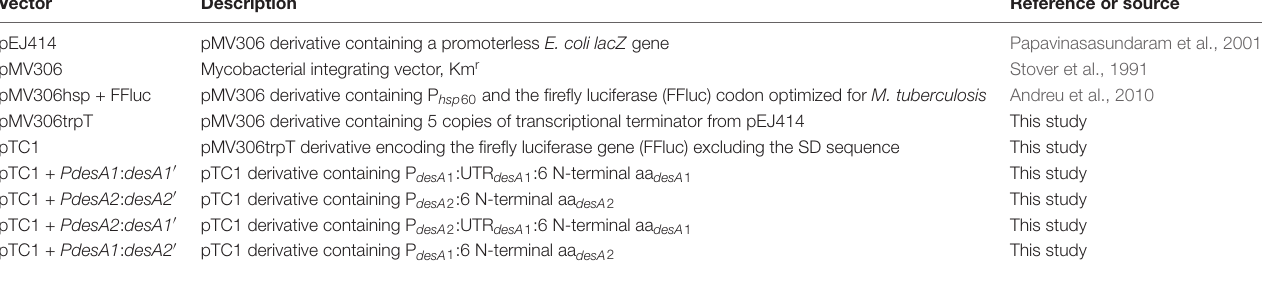
TABLE 2 | Vectors used in this study.